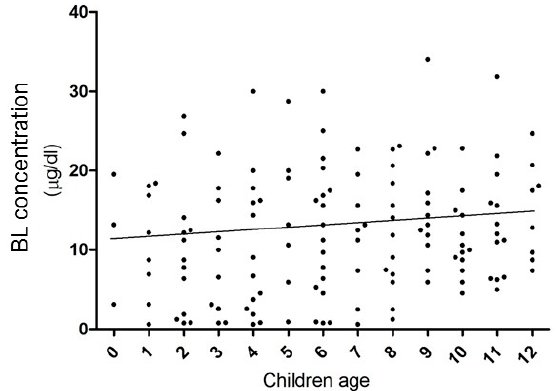
Figure 2. Blood lead levels in terms of age.